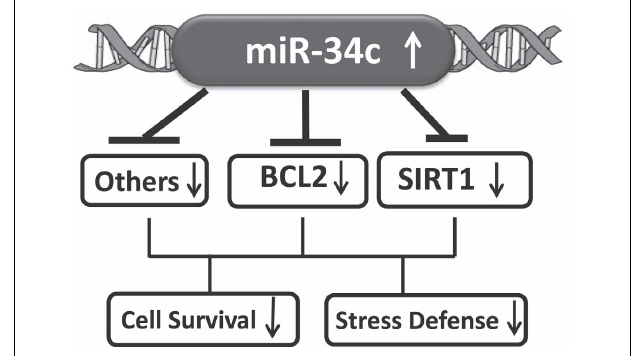
FIGURE 9 | A model suggesting that increased circulating miR-34c expression represses targets involved in oxidative stress and cell survival signaling